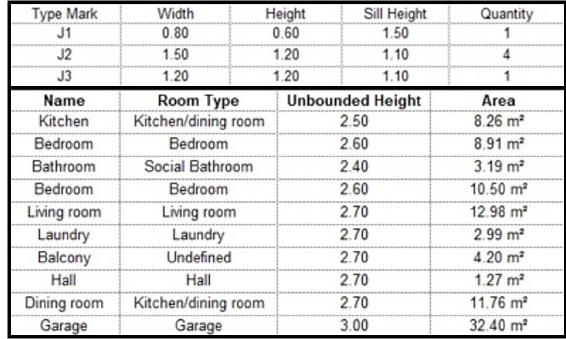
Figure 6. SF building window and room schedule.